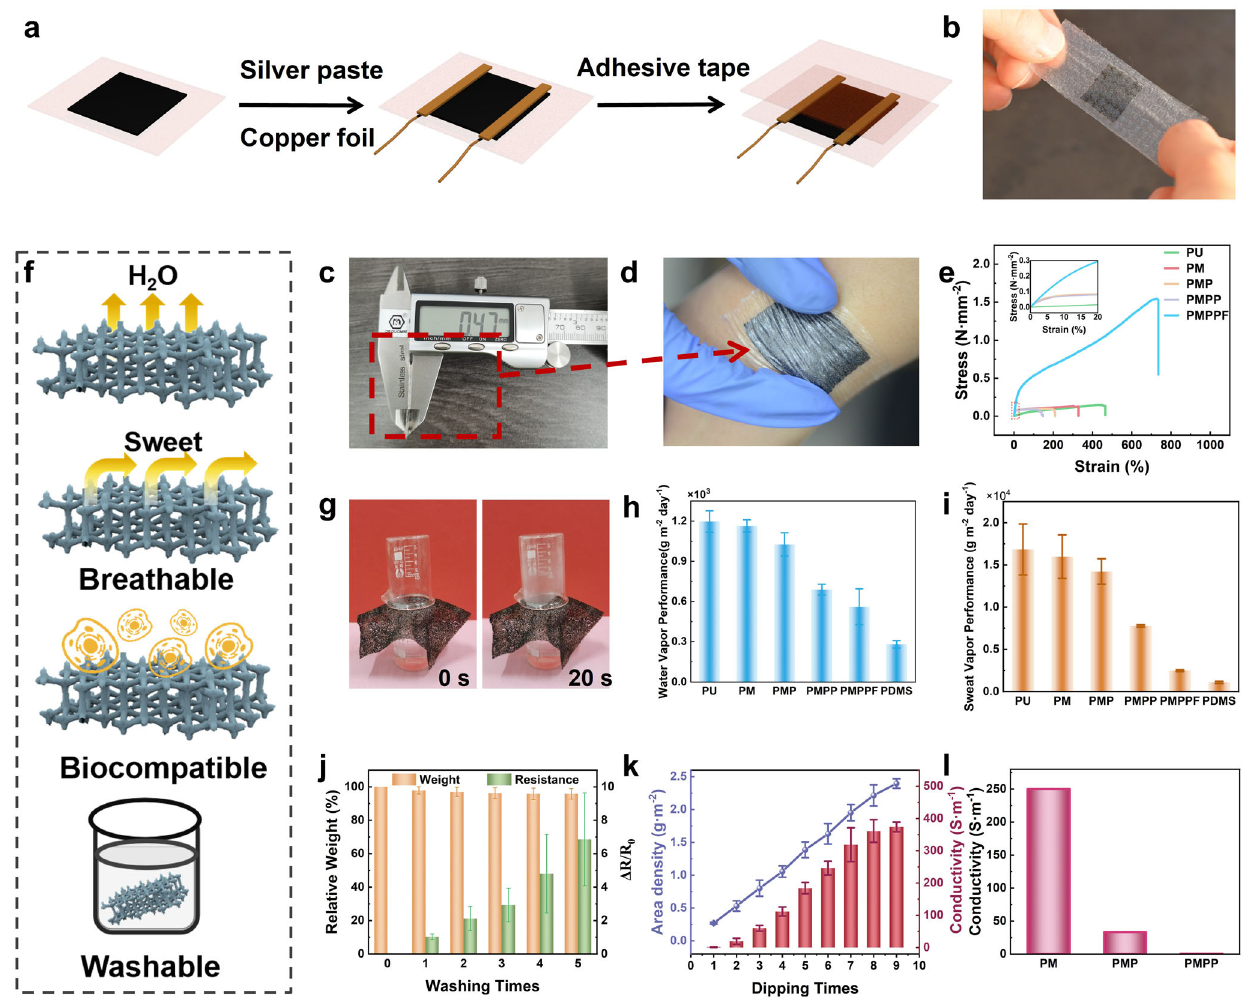
Fig. 3 Fabrication and characterization of breathable and fl exible PMPPF electrical device. a Schematic preparation process of PMPPF. Digital image of ( b ) PMPPF bandage, ( c ) thickness of PMPPF and ( d ) conformal PMPPF. e Strain-stress curves of PU, PM, PMP, PMPP, and PMPPF. f Breathable, biocompatible and washable mechanism for the multifunctional fl exible sensor. g Photograph showing water vapor transmission performance of the breathable hybrid sponge (PMPP). Comparison of ( h ) WVTR and ( i ) sweat vapor performance of different samples (Error bars: s. d., n = 7). j Evolution of the electrical conductivity of PMPP during washing (Error bars: s. d., n = 3). k Conductivity and Area density (MXene weight vs Area) of PU dipping with different times of MXene (Error bars: s. d., n = 3). l Sample conductivity changes of the PM, PMP, and